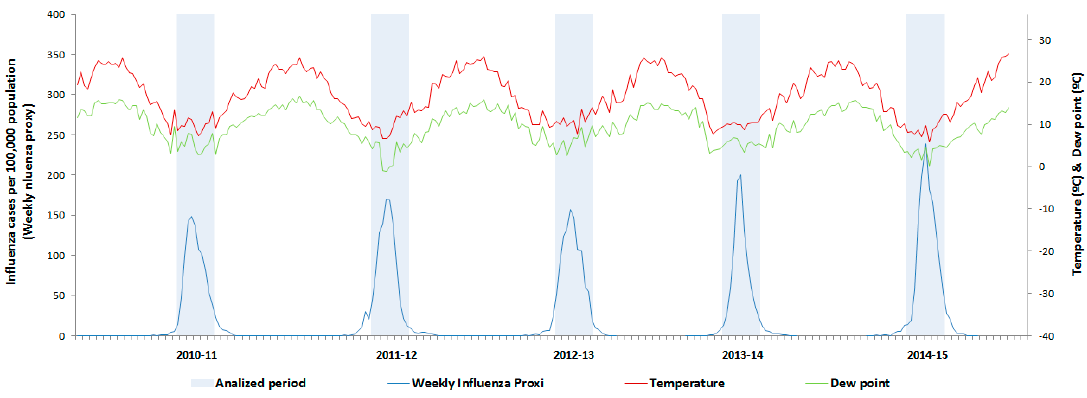
Figure 3. Weekly influenza proxy, mean temperature and dew point, Spain, influenza seasons 2010/11 to 2014/15. • Model 1: Weekly influenza proxy and dew